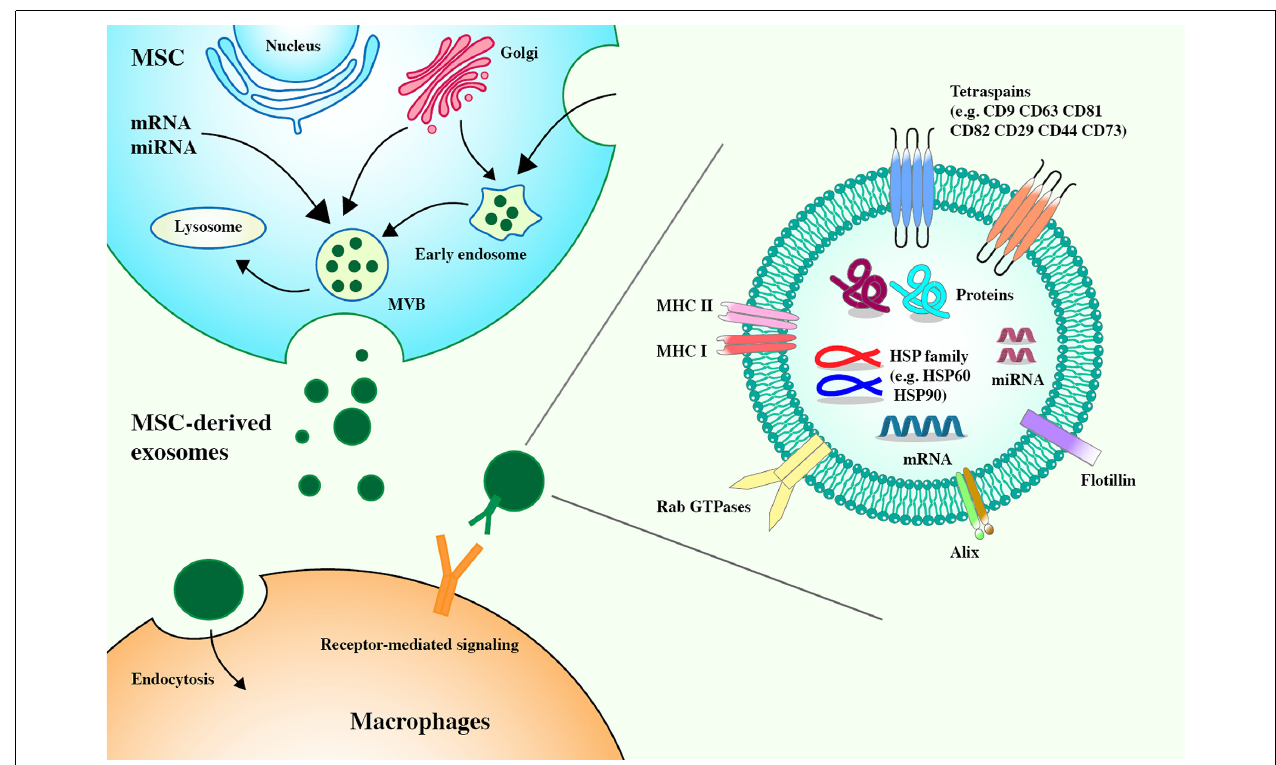
FIGURE 1 | Mesenchymal stem cell-derived (MSC-derived) exosomes express tetraspanins (CD82, CD81, CD63, and CD9), heat shock proteins (HSP60, HSP70, and HSP90), membrane transport, and fusion proteins (GTPase, annexin, and flotillin), ALG-2 interacting protein X (Alix), and adhesion molecules (CD29, CD44, and CD73). Exosomes derived from MSCs carry a complex cargo, including nucleic acids, and proteins. Biogenesis of MSC-derived exosomes. The biogenesis of exosomes includes the formation of early endosomes through the invagination of the plasma membrane, the formation of late endosomes through the selection of cargo, and the formation of multivesicular bodies (MVBs) from late endosomes. MVBs contain intraluminal vesicles. The fusion between MVBs and the plasma membrane results in the release of exosomes. The ways for exosomes to enter recipient cells are receptor-mediated entry and